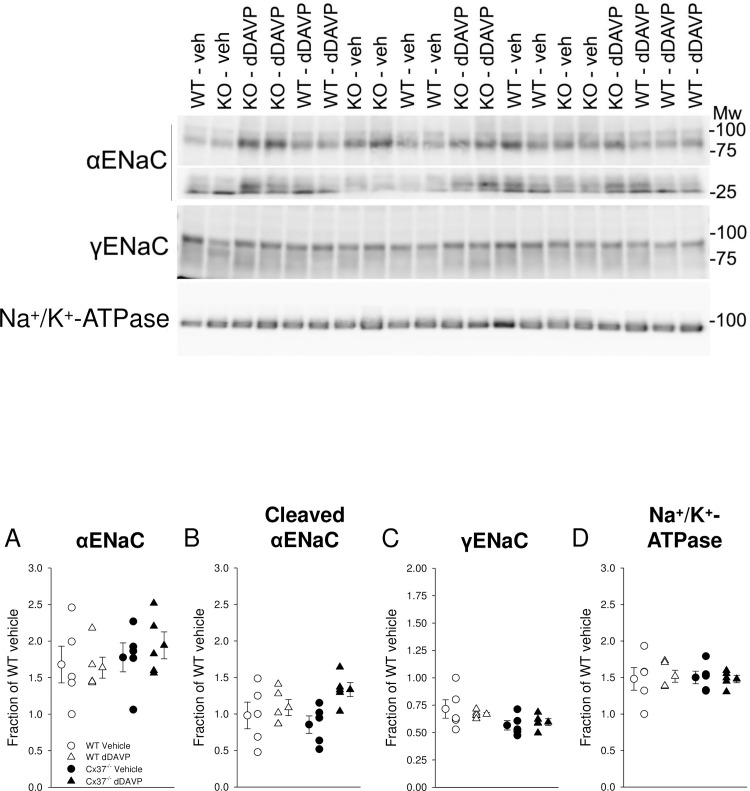
Renal abundance of the epithelial sodium channel and Na+/K+-ATPase.Sixty minutes after vehicle application no differences were observed in (A) αENaC, (B) cleaved αENaC, (C) γENaC or (D) Na+/K+-ATPase abundance. Systemic administration of dDAVP following suppression of endogenous arginine-vasopressin overnight (see Materials and methods for details) did not affect abundances of these proteins. Data are expressed as mean ± SEM and analyzed by paired and unpaired Student’s t-test, n = 5 each genotype and condition.